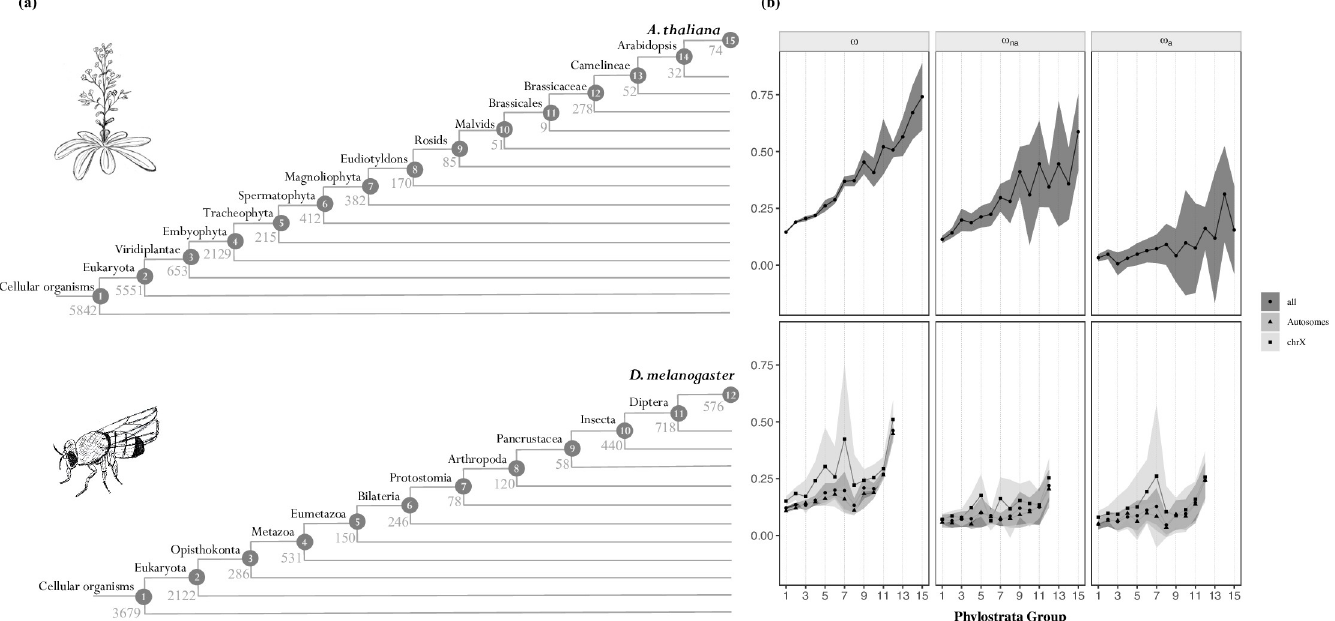
Fig 1. (a) Phylogenetic definition of the strata used in the analyses for A . thaliana (top) and D . melanogaster (bottom). The number of genes mapped to each clade is shown. (b) Relationship between the rate of protein evolution ( ω ), nonadaptive nonsynonymous substitutions ( ω na ), and adaptive nonsynonymous substitutions ( ω a ) with gene age in A . thaliana (top) and in D . melanogaster (bottom). Clades are ordered according to (a). In D . melanogaster , the results for X-linked, autosomal, and total genes are shown. Mean values of ω , ω na , and ω a for each category are represented with the black points. Error bars denote for the 95% confidence interval for each category, computed over 100 bootstrap replicates. The data (S1 Data) and code needed to generate this table can be found at https://gitlab.gwdg.de/molsysevol/ supplementarydata_geneage and https://zenodo.org/record/6828430.